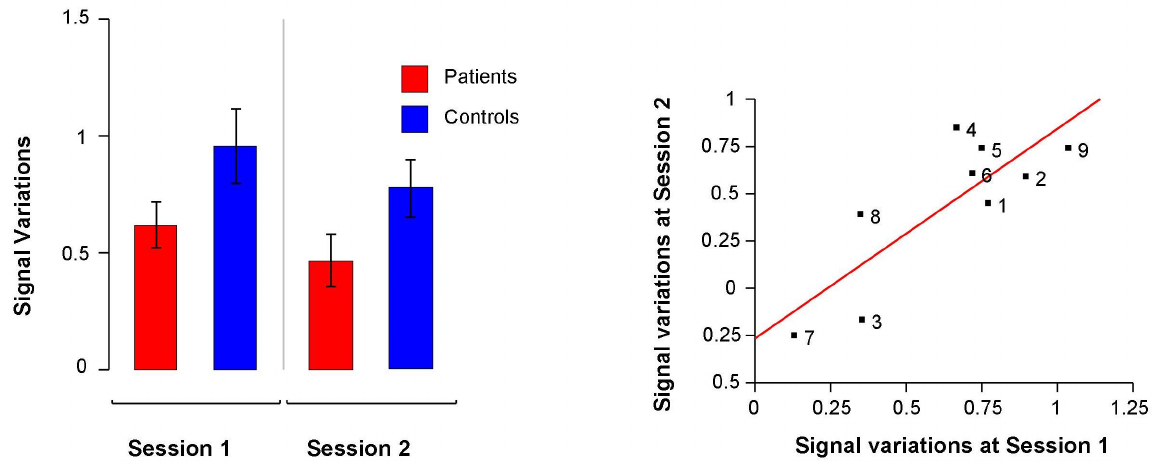
Figure 3. Left: Mean signal variations at baseline and at the second fMRI session in the functional Region Of Interest (fROI) in schizophrenia patients and in healthy participants. Right: Correlation between mean signal variations in the fROI at baseline and at the second fMRI session in schizophrenia